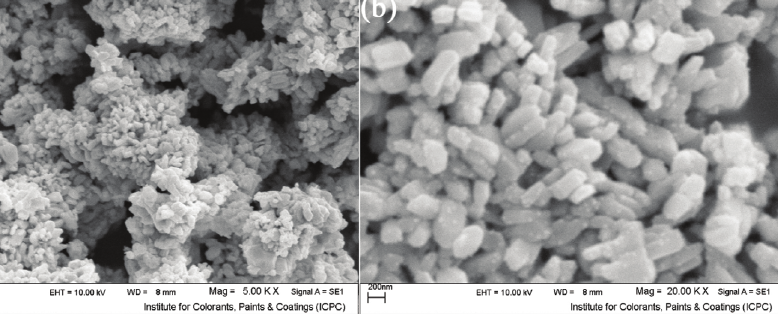
Figure 14 (a, b): SEM image of sample no. 6 with 5 KX and 20 KX magnification,